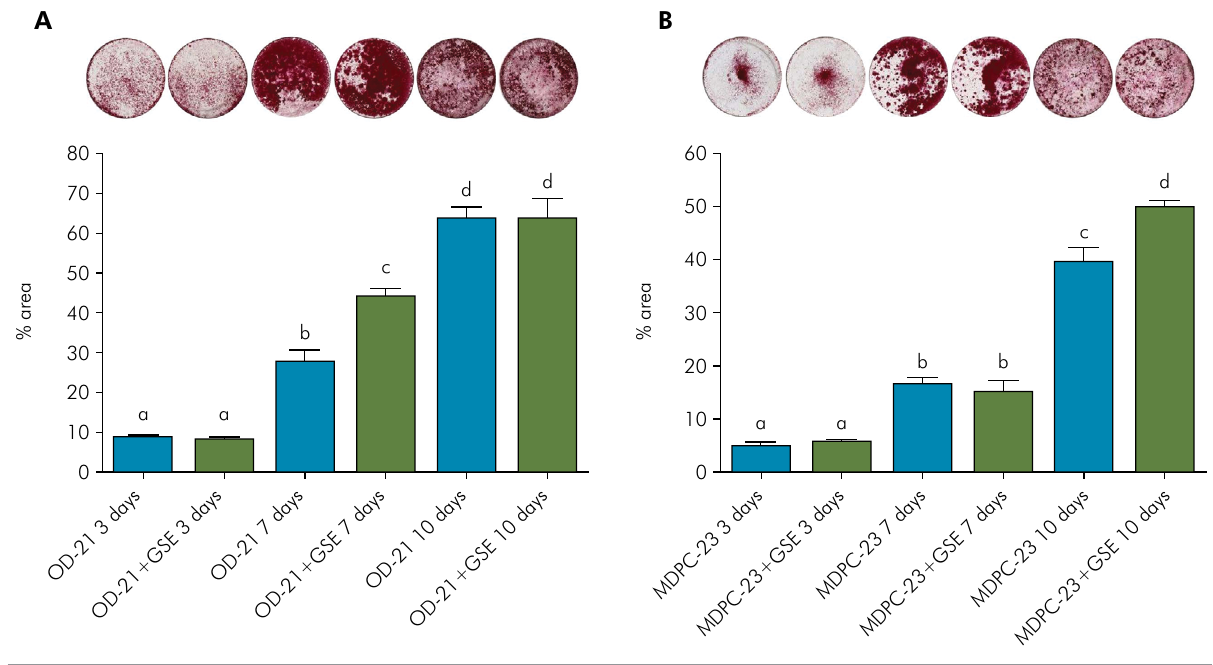
Figure 3. OD-21(A) and MDPC-23(B) quantitative and qualitative alkaline phosphatase (ALP) in situ detection after 3, 7 and 10 days. Different letters mean statistical difference set at 5%